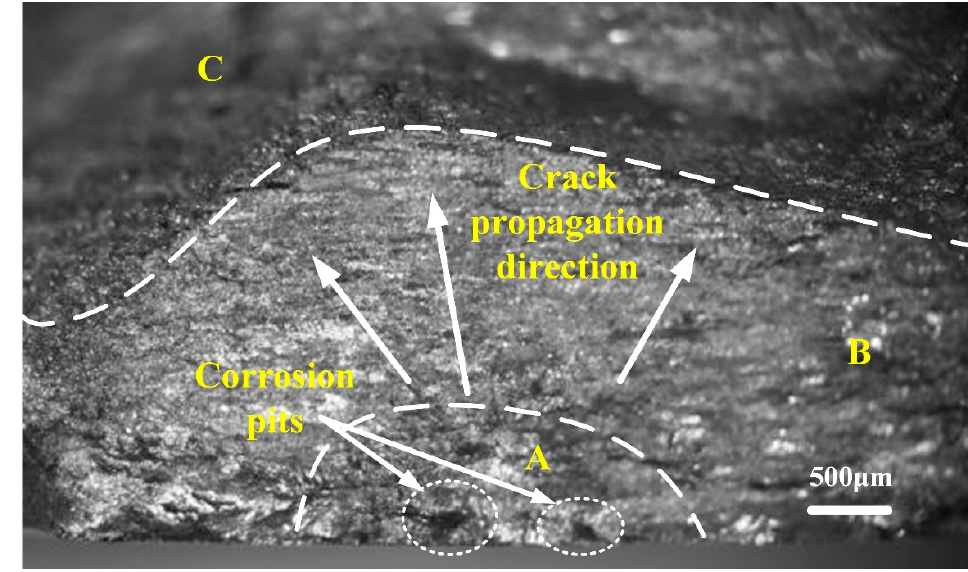
Figure 4. Morphologies of fracture specimen for 2524-T3 aluminum alloy at 180 MPa stress level.